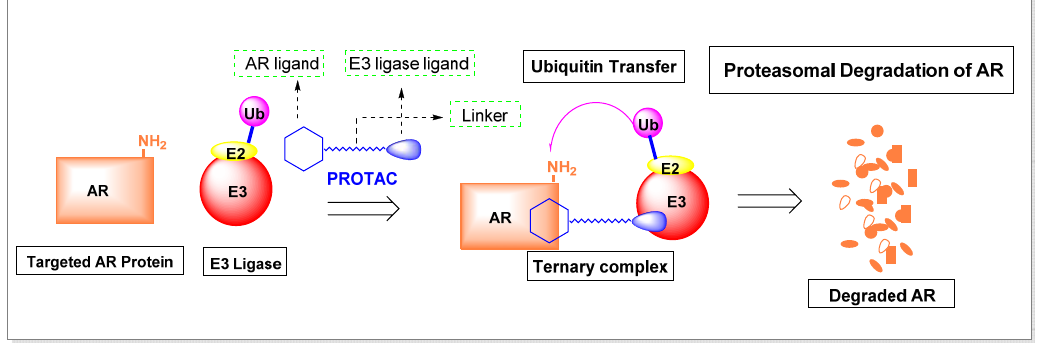
Figure 3. Mechanism of action of AR-directed proteolysis-targeting chimeras (PROTACs). The AR ligand warhead binds AR and the E3 ligase warhead binds to E3 ligase, forming a ternary complex. The ternary complexes allow for efficient catalysis of the transfer of ubiquitin (Ub) to lysine (NH 2 ) residues on the AR, targeting AR to be destroyed by the proteosome.